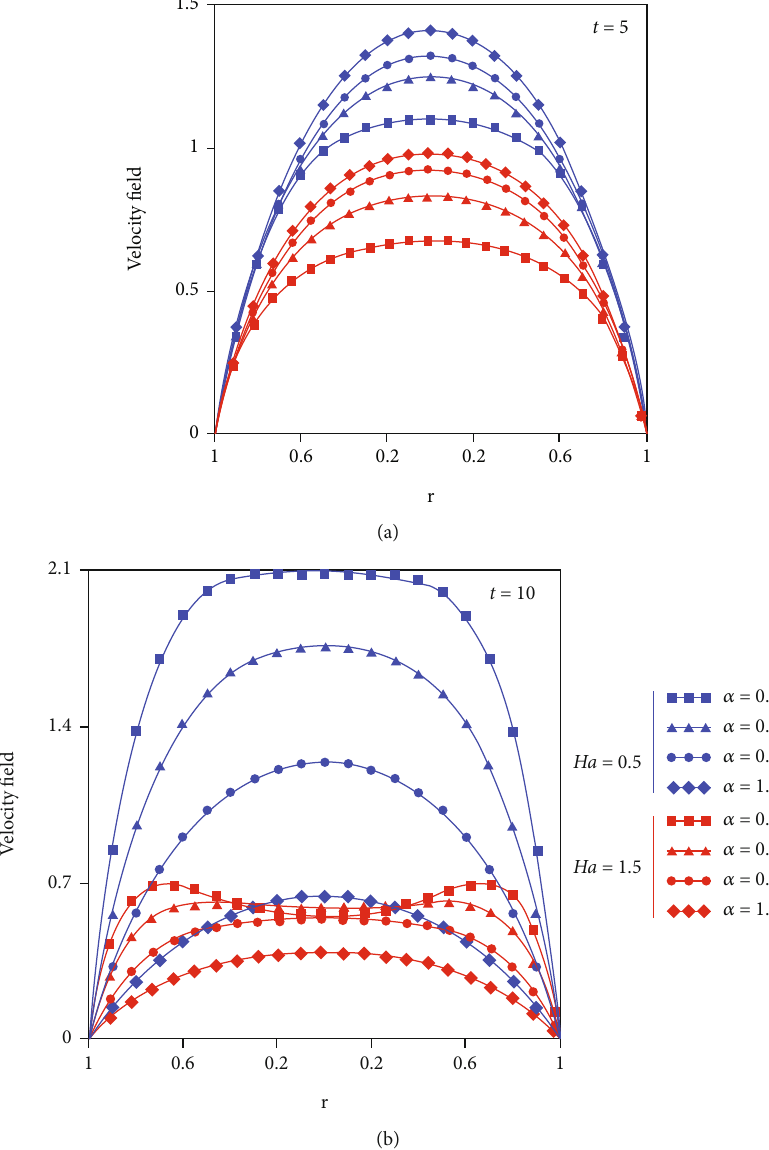
Figure 5: Pro fi les of dimensionless velocity for α versus r at Re = 2 : 5, Ha = 0 : 5, 1 : 5, K = 1, n = 0 : 8, for small and large values of time t